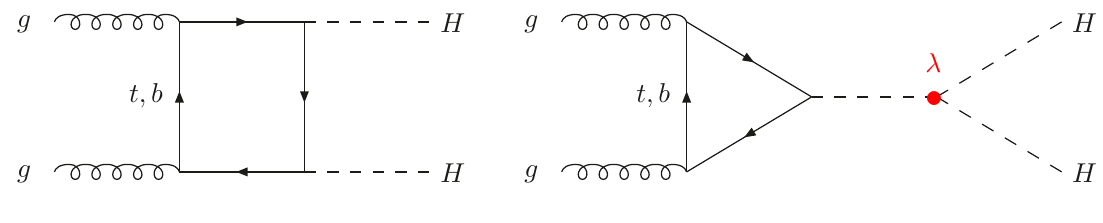
Figure 1 . Diagrams contributing to Higgs-boson pair production via gluon fusion. The contribution of the trilinear Higgs coupling is marked in